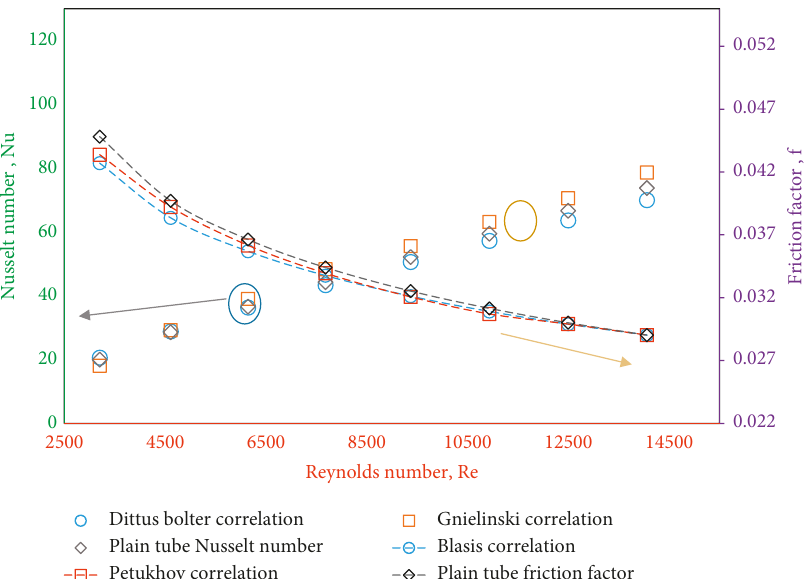
Figure 7: Validation of the plain tube.